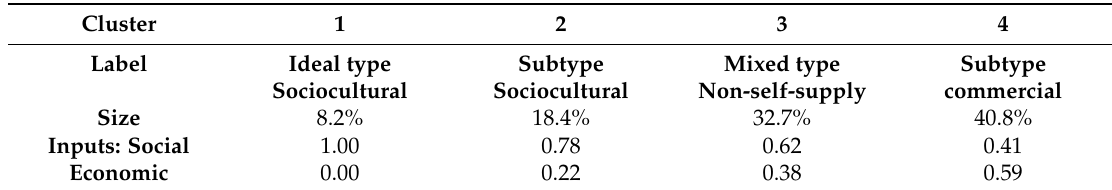
Table 3. Results of Two-Step Cluster Analysis Using Variables for Social and Economic Relevance.